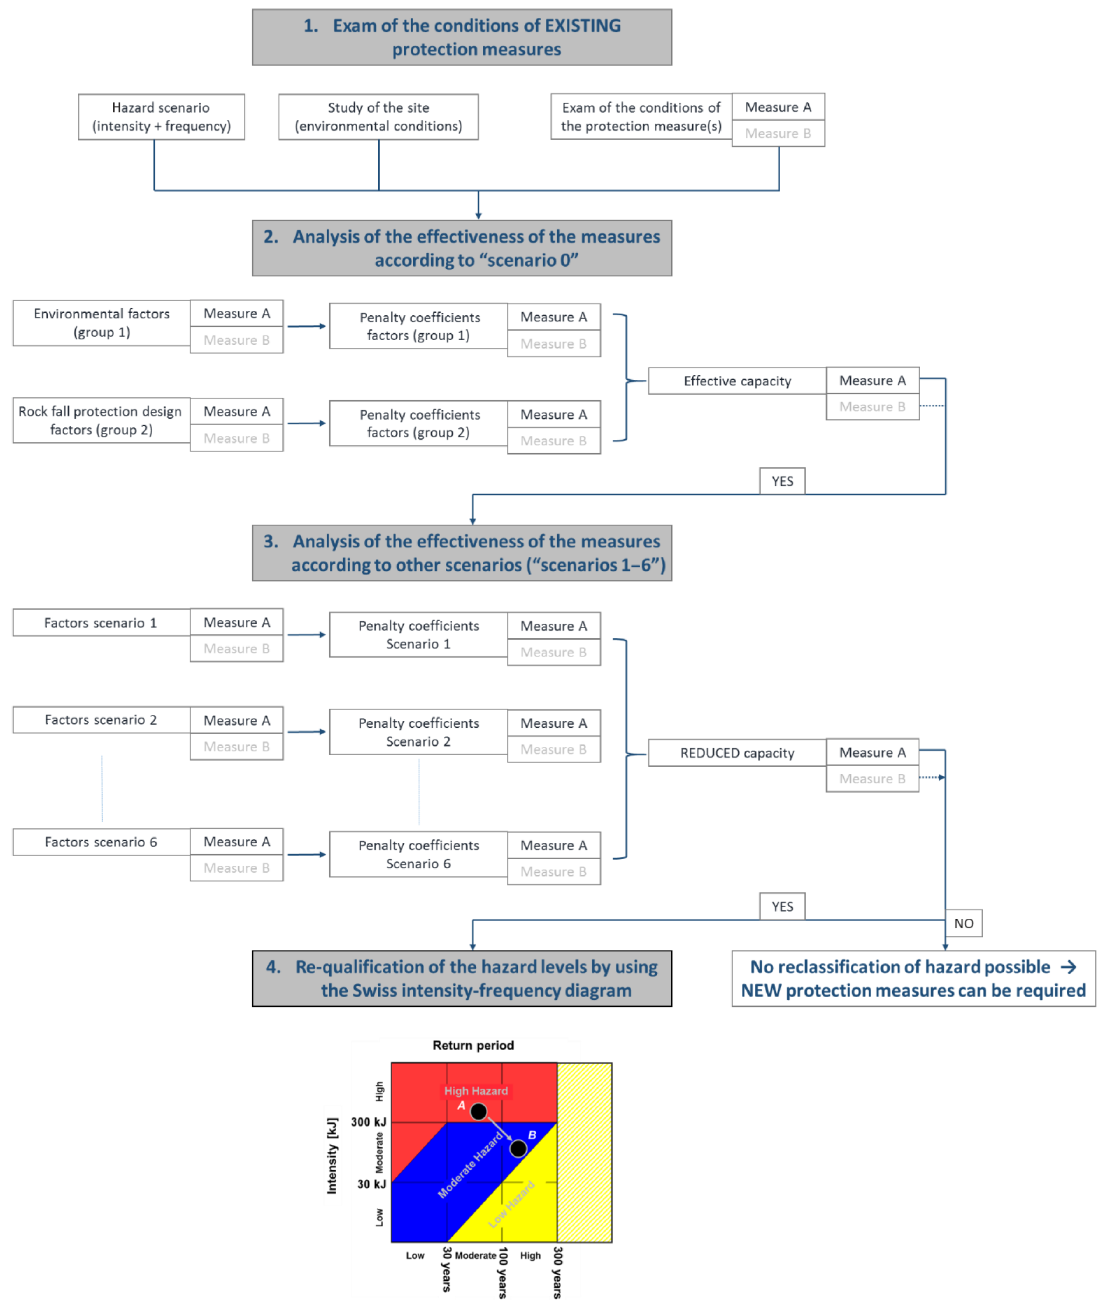
Figure 8. Flow chart of the application of the methodology for existing protection measures (options written in light grey and dotted arrows are referred to the possibility of taking into account more than one protection already existing at a study